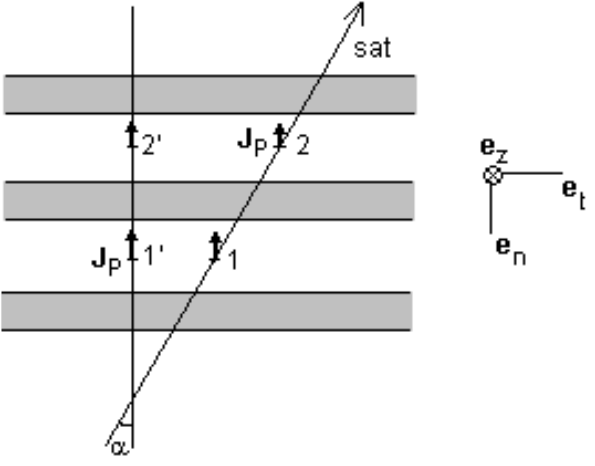
Fig. B1. Schematic picture of the FAC closure system through the ionosphere via Pedersen currents. The view is from above the iono- sphere. α is the incidence angle of the spacecraft. 1 0 and 2 0 are arbitrary points located between different current sheets. 1 and 2 are the corresponding points located along the satellite trajectory. J P denotes the Pedersen current